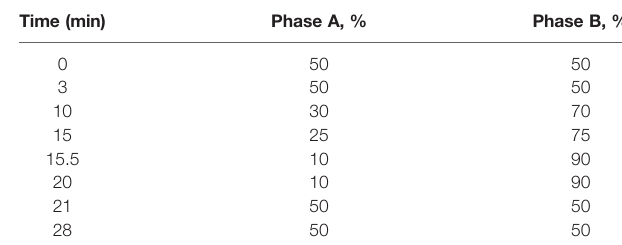
TABLE 1 | Gradient elution mobile